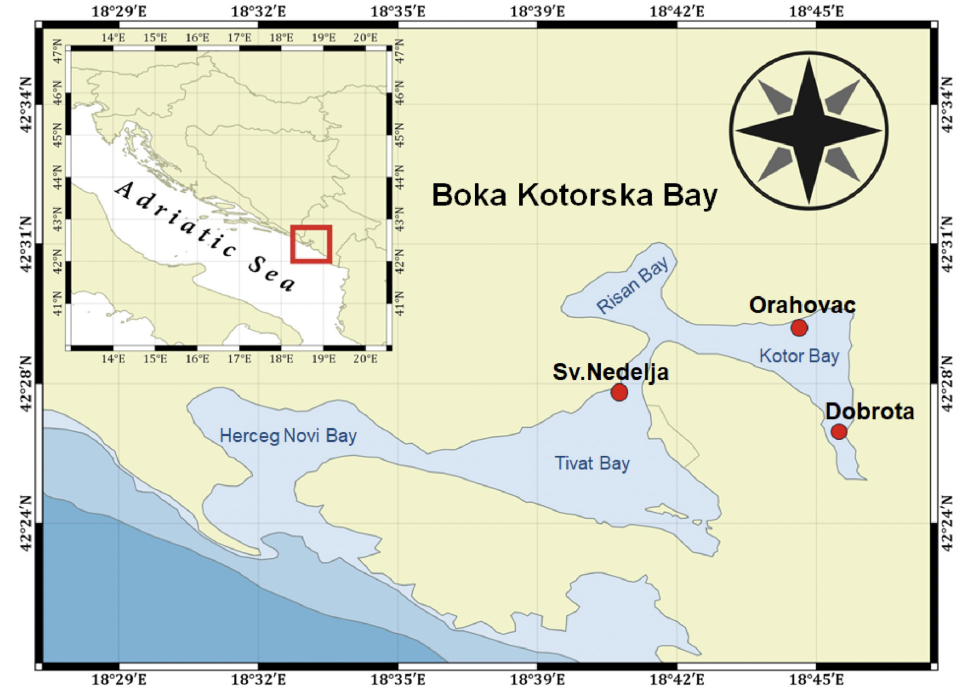
Figure 1. Map of Boka Kotorska Bay, Montenegro, showing the three locations where the investigated samples were